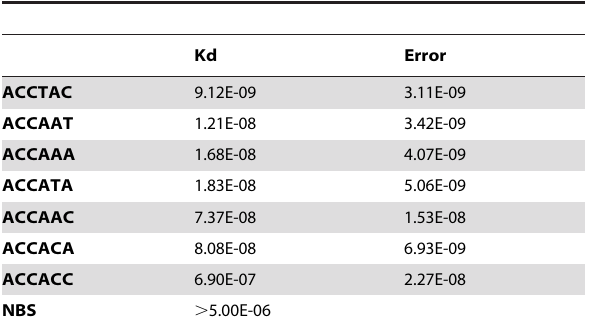
Table 4. Dissociation constants (K d ) in mol/L and associated errors of mutated ACCTAC (AC1 element)